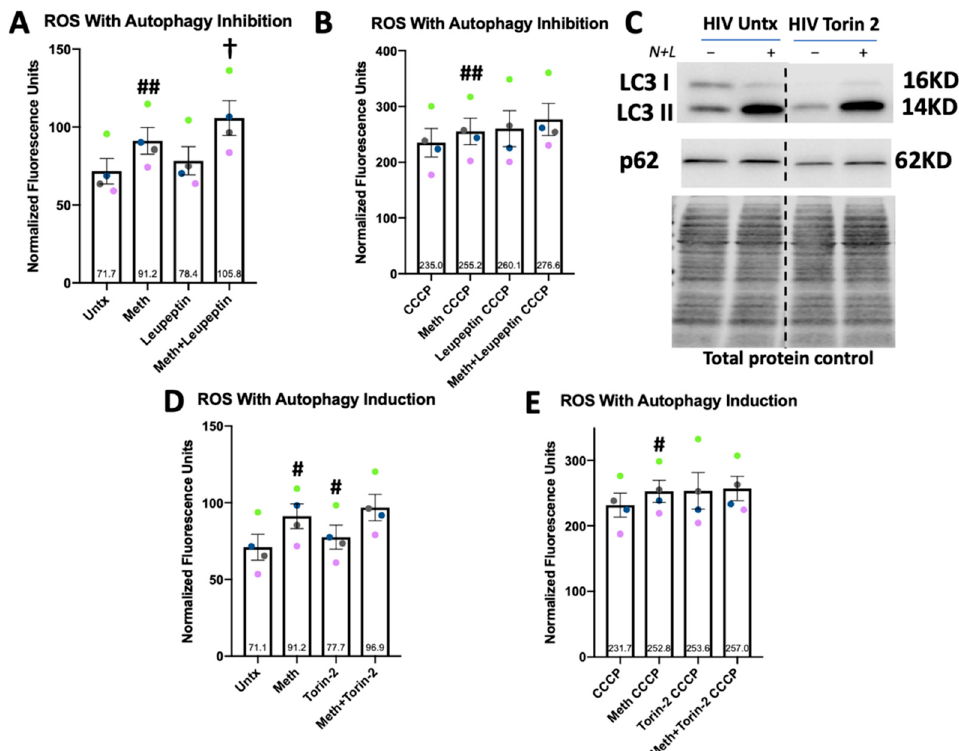
Figure 7. Meth-mediated upregulation of ROS is increased when lysosomal degradation is inhibited but not when autophagy is induced. ( A ) A total of 200 µM of leupeptin, which inhibits autophagic flux, was added in the last 4 h of 24 h treatment, and ROS were detected by fluorometry as described. ( B ) Same experiments as in ( A ) with CCCP alone as the untreated control. ( C ) Western blotting for LC3 and p62 in HIV-infected MDM treated with 500 nM of Torin 2, an mTOR inhibitor, for 3 h, demonstrating increased LC3II flux and decreased p62 levels. ( D ) A total of 500 nM of Torin 2, which induces autophagy, was added in the last 3 h of 24 h treatment, and ROS were detected by fluorometry as described. ( E ) Same experiments as in ( D ) with CCCP alone as the untreated control. n = 4, # p < 0.05, ## p < 0.01 meth or Torin 2 alone compared to untreated by one-way ANOVA; † p < 0.05 meth compared to meth + leupeptin by one-way ANOVA. Error bars represent SEM.